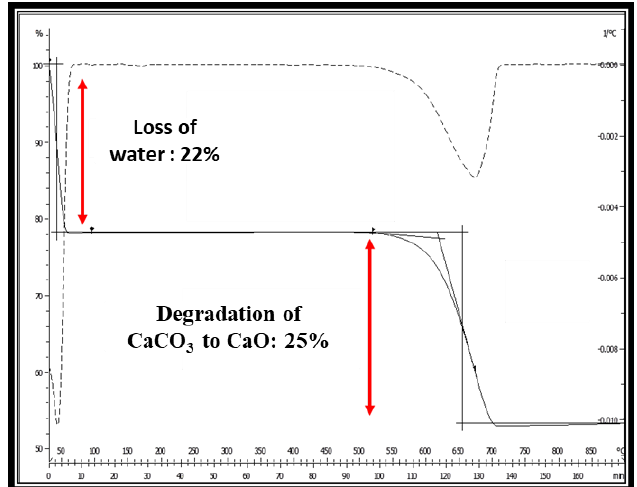
Figure 9. TGA of CaCO 3 .